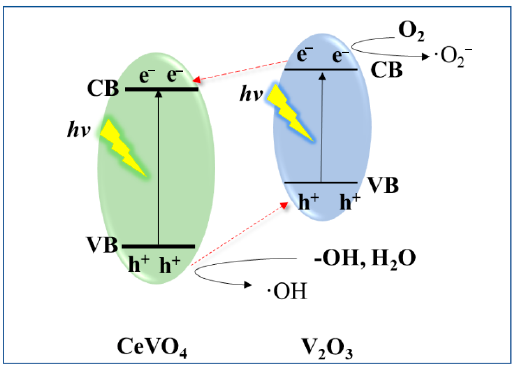
Figure 7. The photocatalytic mechanism of CeVO 4 -V 2 O 3 sample prepared with 10 mL EG.